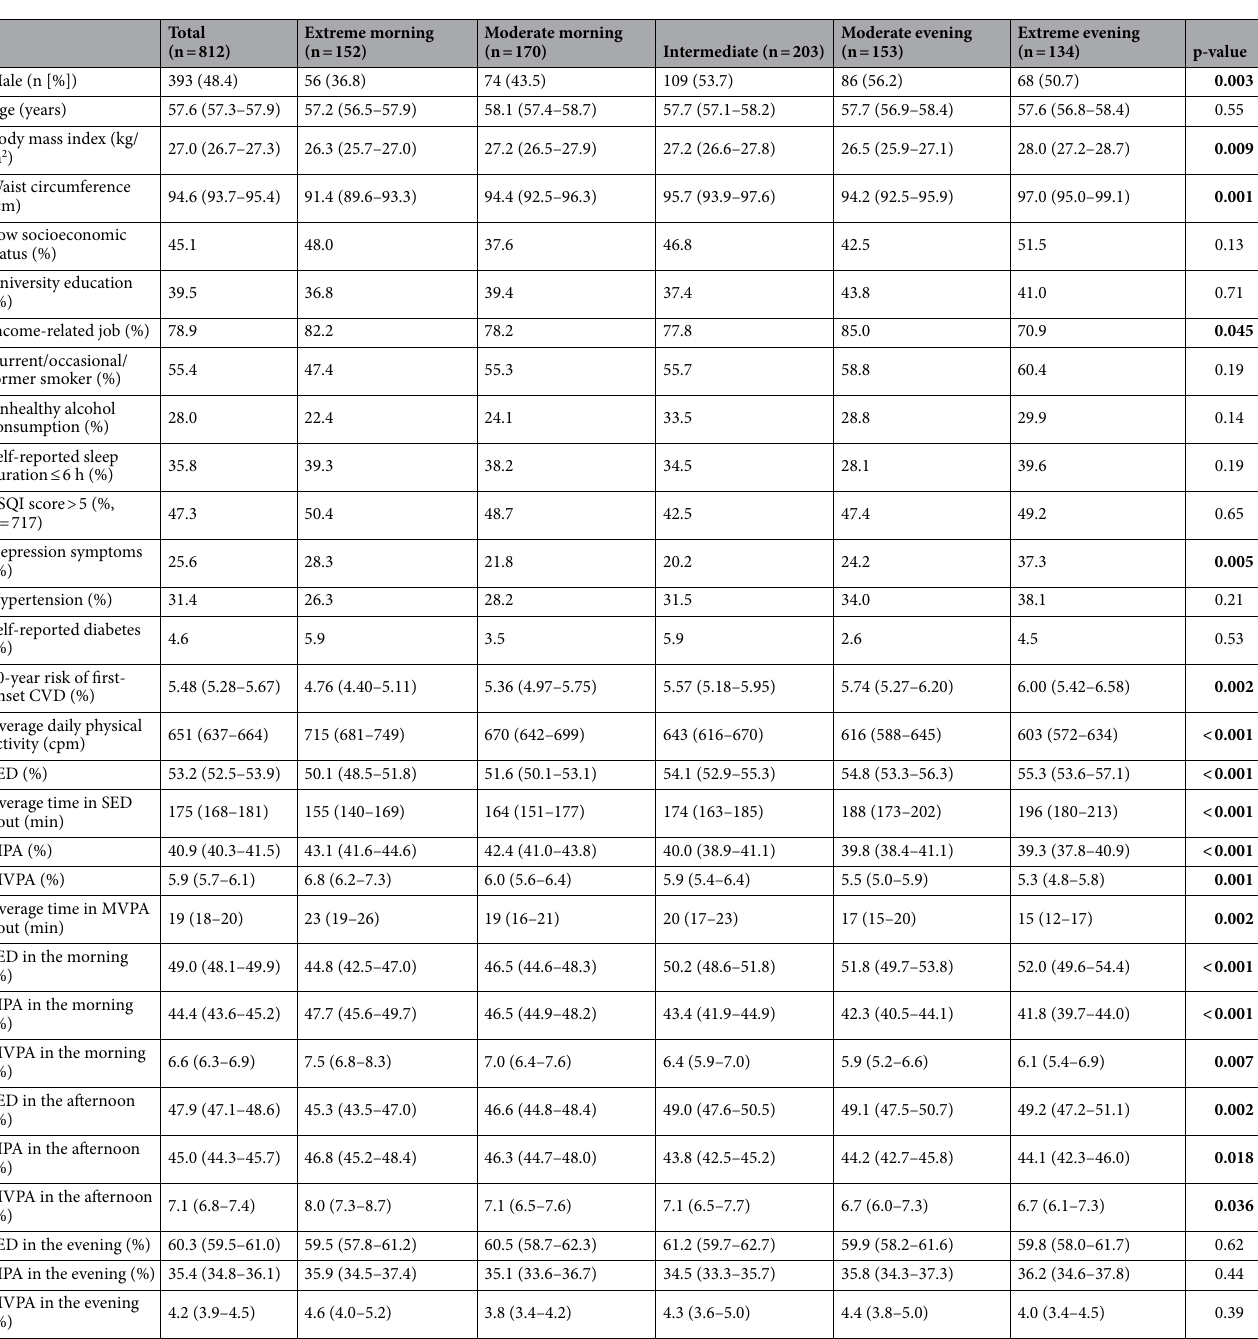
Table 1. Characteristics and physical activity patterns of the population. Data shown as percentage or mean (95% CI). cpm counts per minute, LIPA light physical activity, MVPA moderate to vigorous intensity physical activity, SED time spent